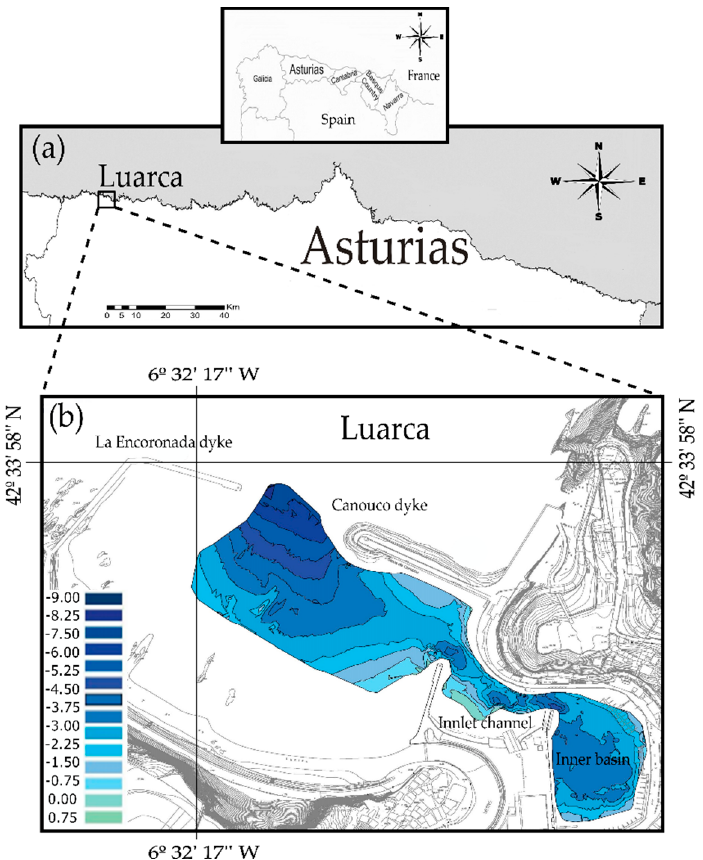
Figure 1. The Port of Luarca: ( a ) position of the port on the Cantabrian Sea coast; ( b ) the study site location.